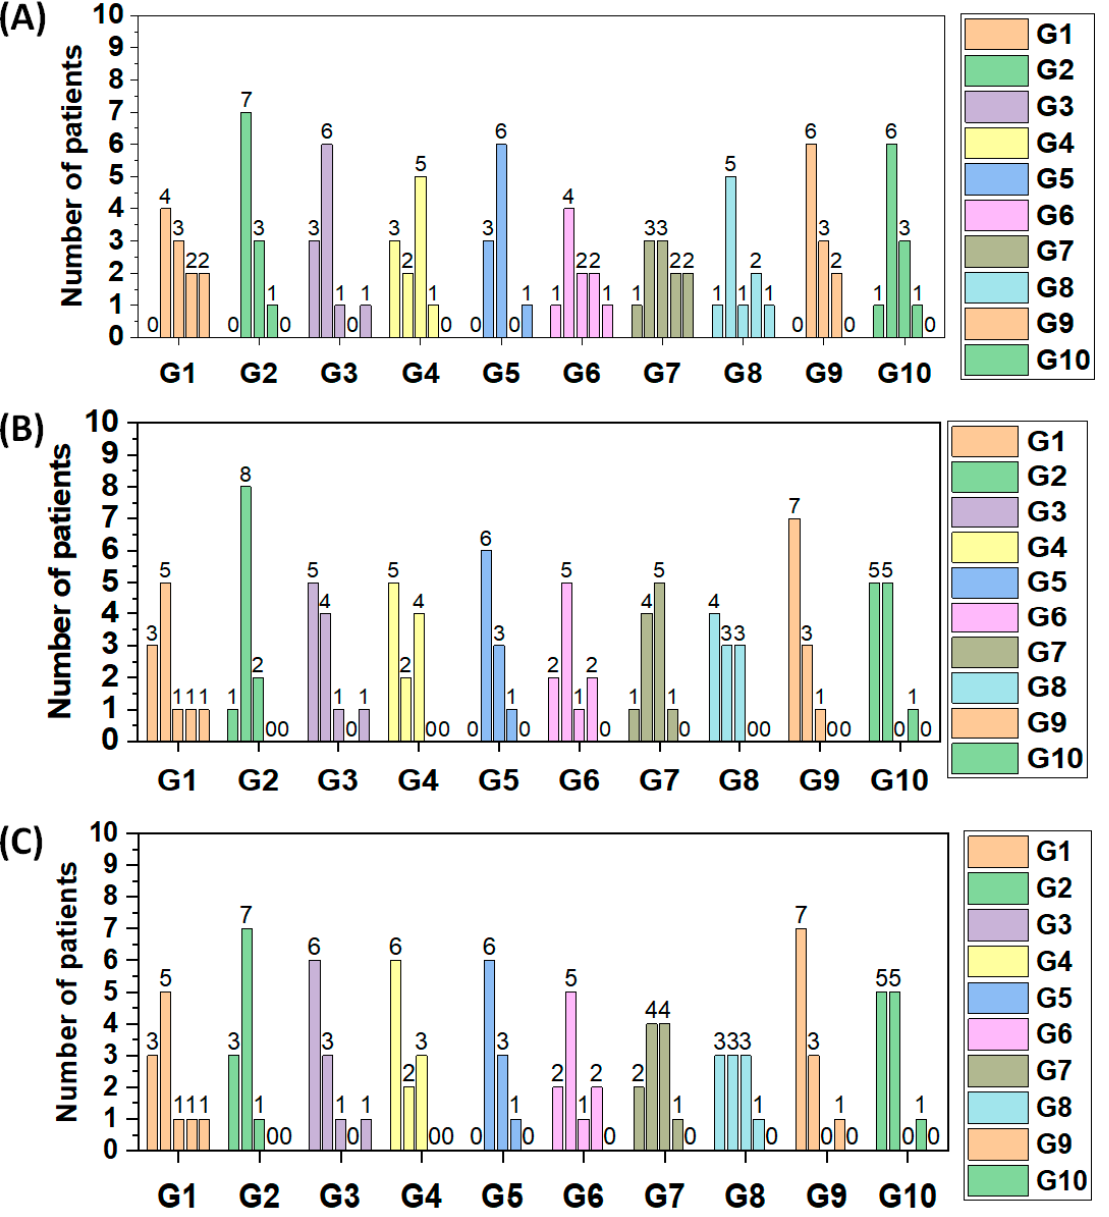
Figure 6. Evolution of the number of patients at each tinnitus grade after each period of each treatment. Barplot comparing the grades of tinnitus at ( A ) T 0, ( B ) T 1 and ( C ) T 2 between tinnitus treatment modalities explored in this study (from G1 to G10). The bars from left to right indicate the number of patients from grade 1 to grade 5, respectively. Grade 1: THI scores from 0–17. Grade 2: THI scores from 18–36. Grade 3: THI scores from 37–56. Grade 4: THI scores from 57–76. Grade 5: THI scores from 77–100. The assessment and division of grades based on THI scores was based on the work of Ferreira et al. [18].